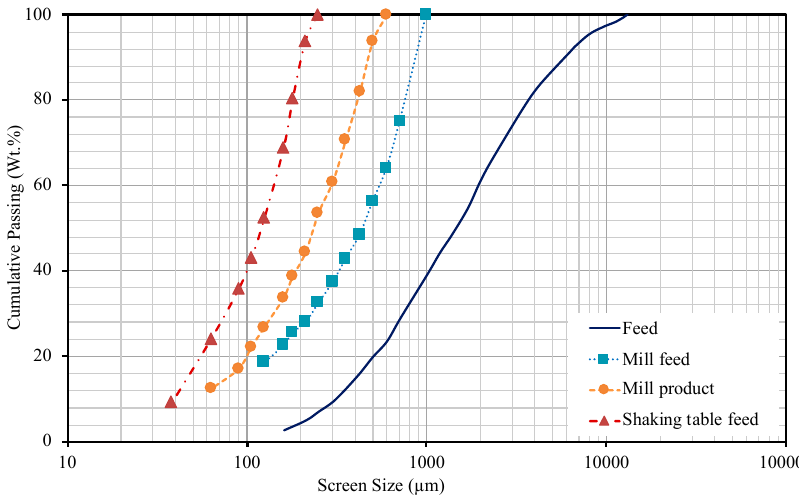
Figure 5. Particle size distribution of the feed, mill product, concentrate, and tailings of the ore sample obtained from gravity separation.